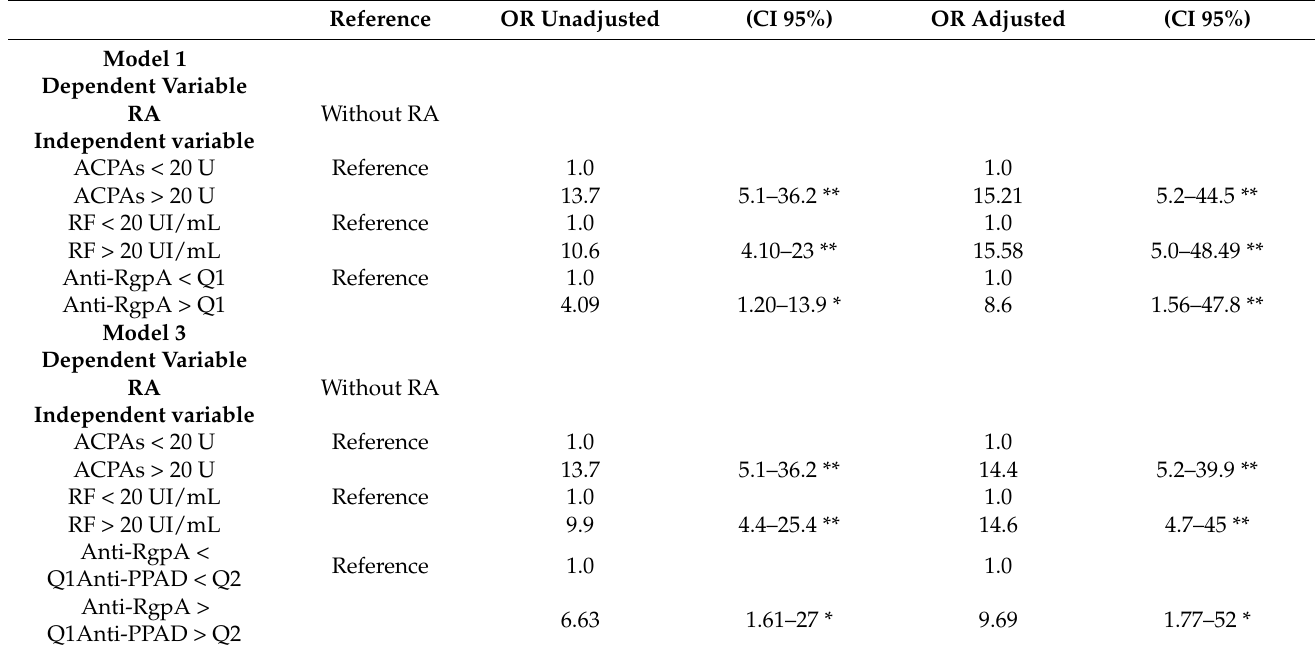
Table 4. Regression logistic model of the markers associated with